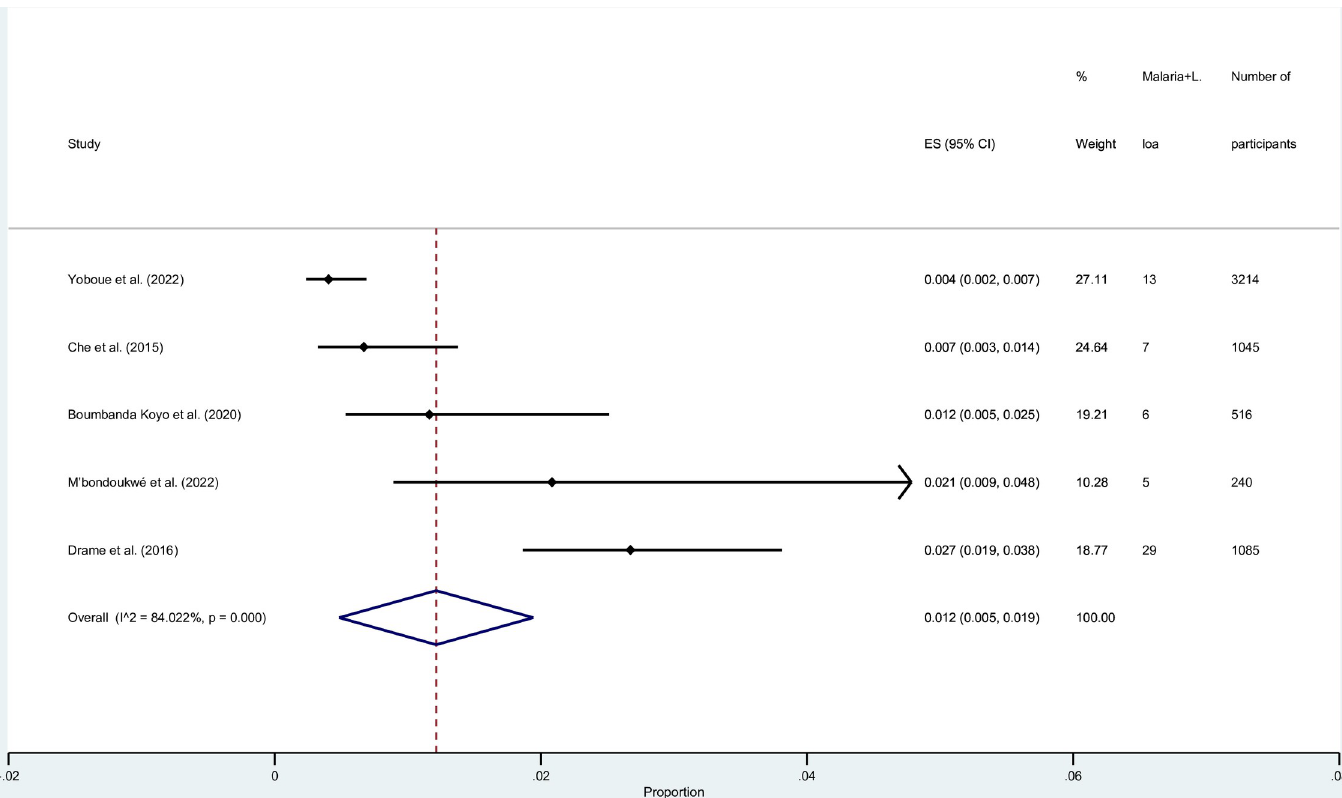
Fig 5. The prevalence of malaria and L . loa co-infections among selected studies. Abbreviations : ES- prevalence estimate; CI- confidence interval.